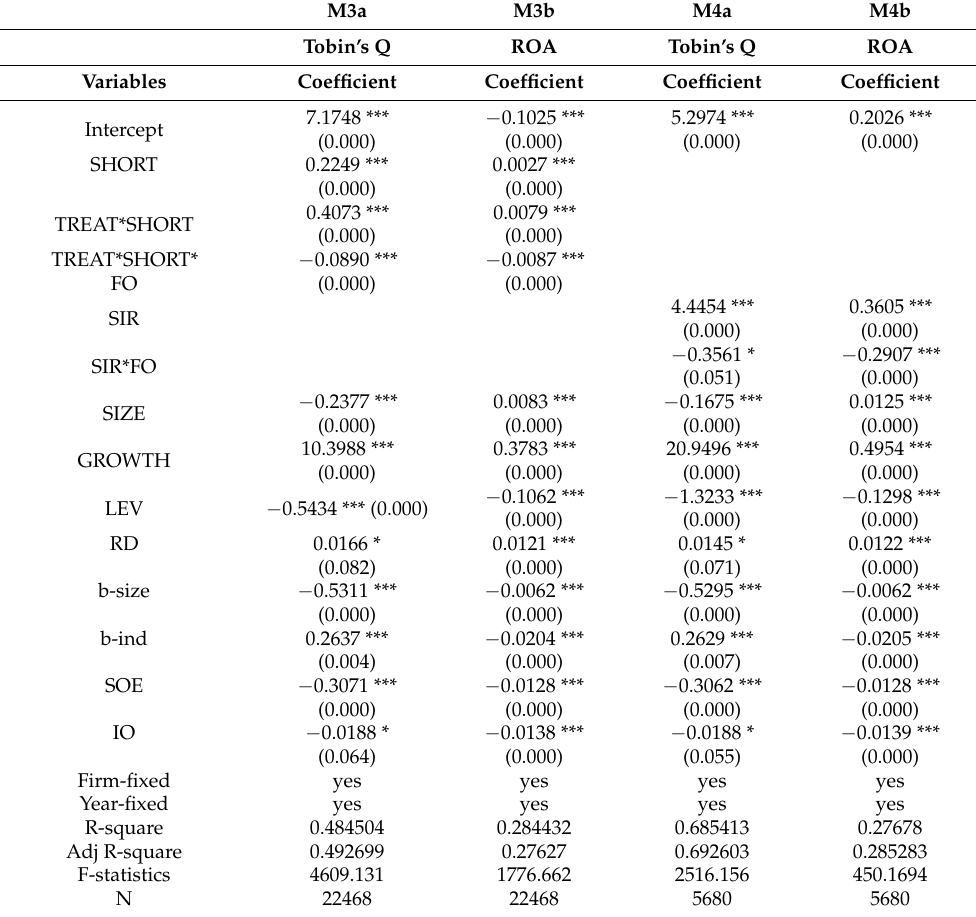
Table 7. Short-selling, family ownership and firm